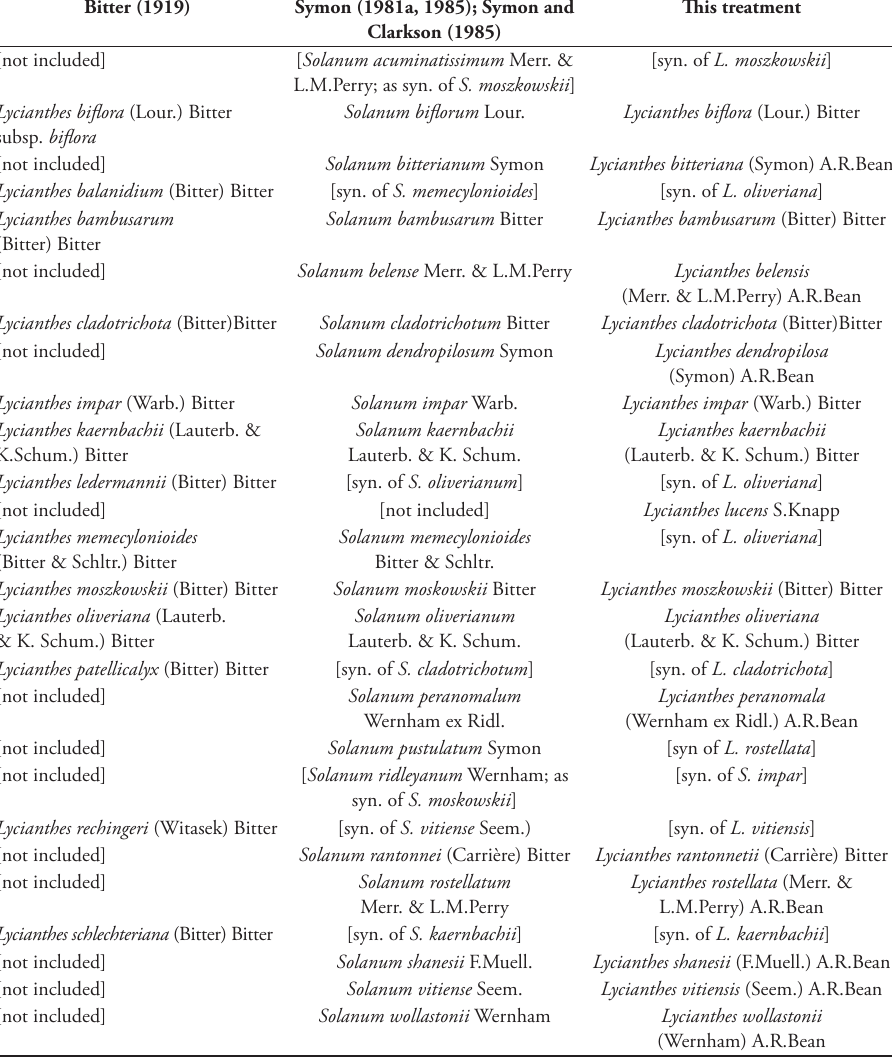
Table 1. Comparison of species recognised in Bitter (1919), Symon (1981a, 1985; Symon and Clarkson 1985) and this treatment. Bold face type indicates accepted species by the relevant authors. Species treated as synonyms are in square